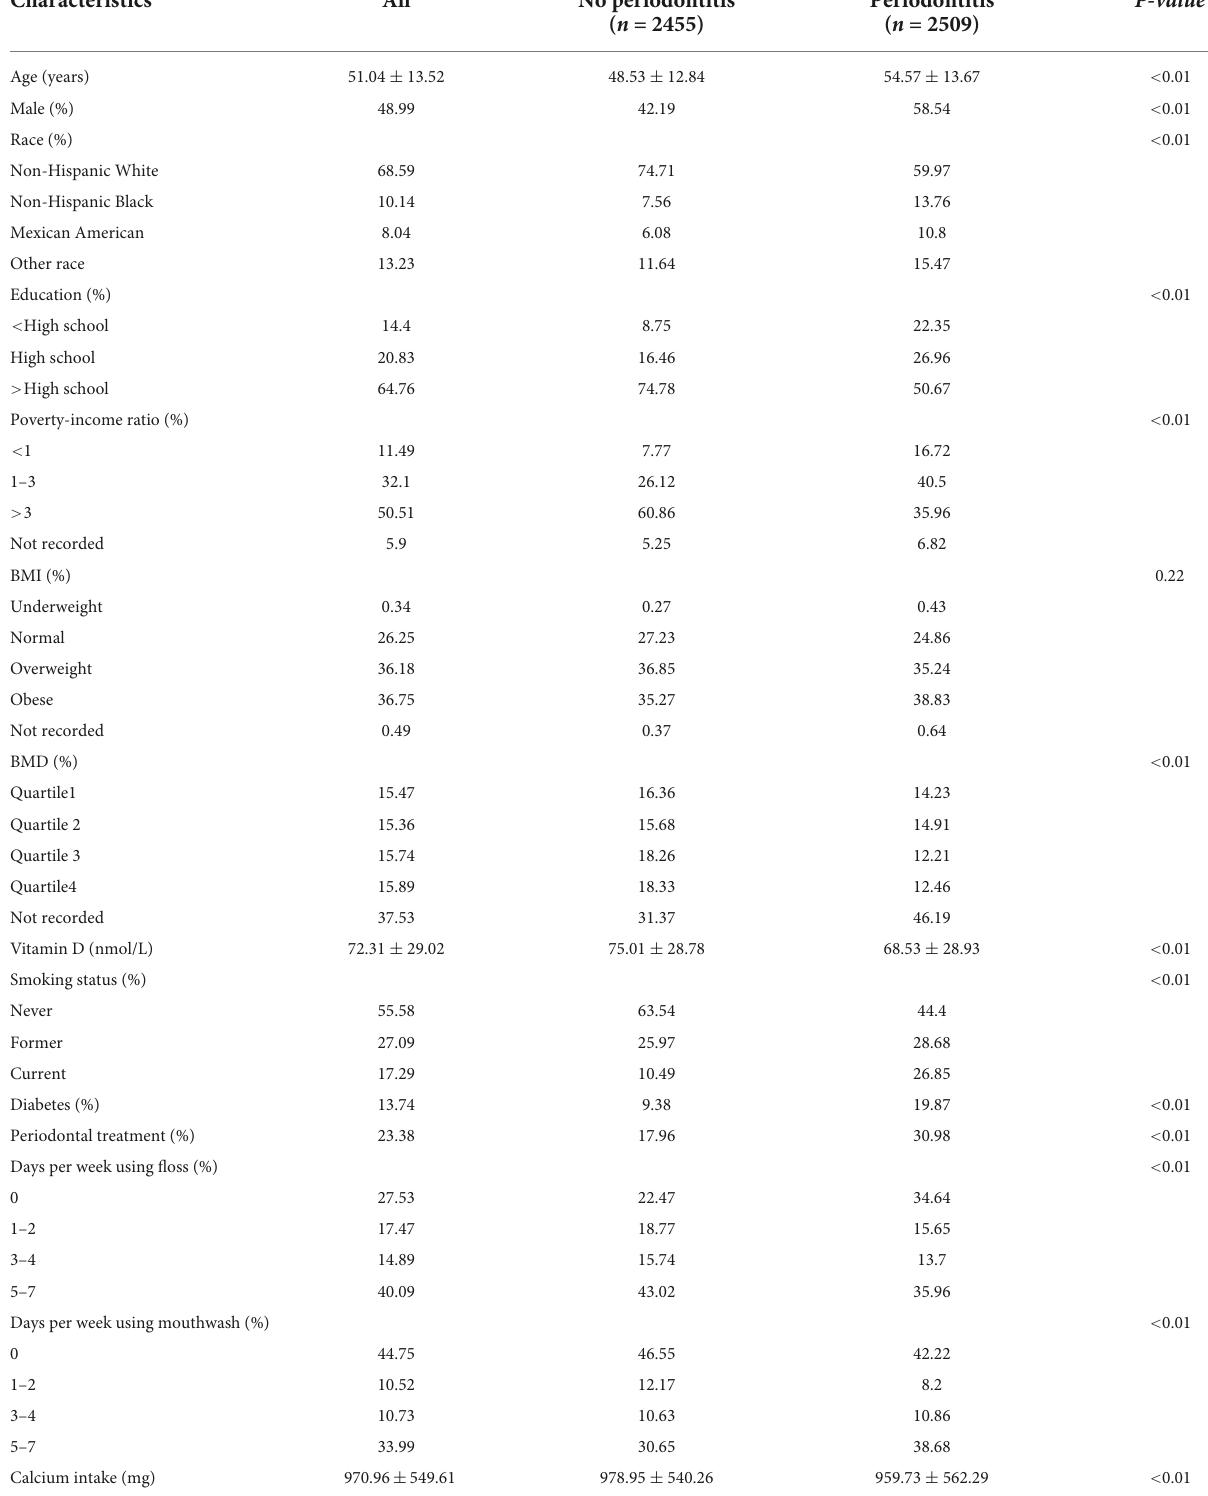
TABLE 2 Characteristics of the 4,964 participants with and without periodontitis.